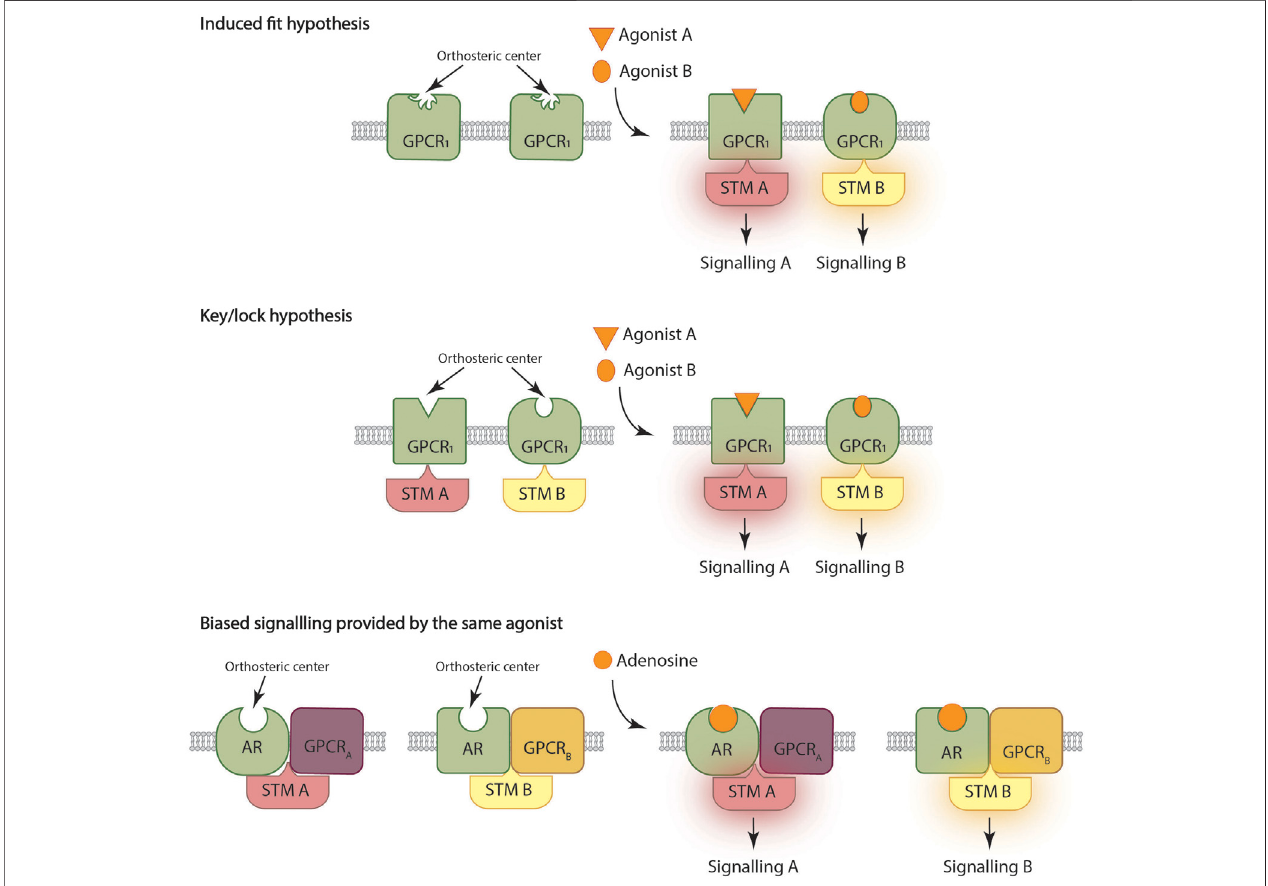
FIGURE 1 | Three ways to deliver biased signaling. Top: G protein coupled receptor (GPCR) orthosteric center of the GPCR has a loose conformation that is fi xed upon agonist binding, thus allowing coupling and engagement of the signal transduction machinery (STM). Center: There are different conformational states of a given GPCR with structurally different orthosteric sites; each agonist preferentially binds to a given conformation thus preferentially engaging a given STM. Bottom: A given ligandactingonagivenGPCRmayleadtodifferentsignalingoutputsdependingonthecontextofthereceptor.Thecaseofheteromerformationisexempli fi edwith a given adenosine receptor (AR) able to interact with GPCR A or with GPCR B .